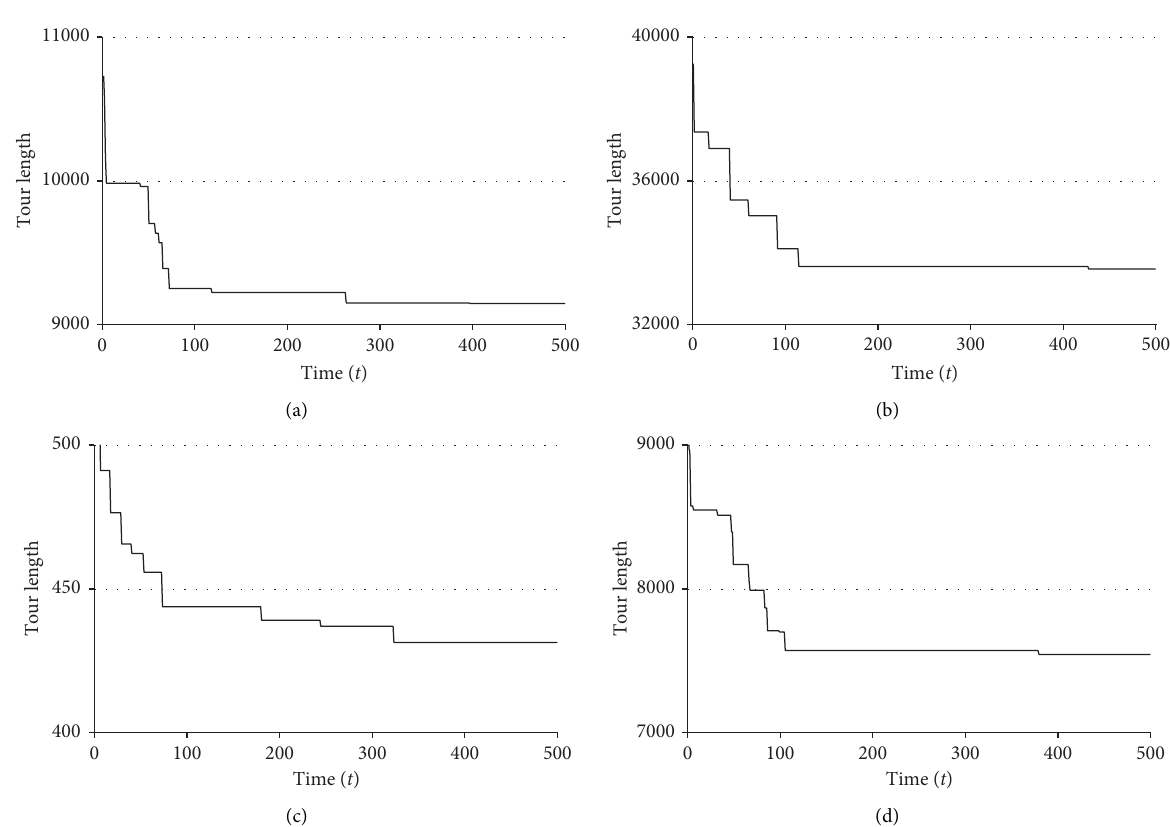
Figure 3: Best solution update in ASIM. (a) bayg29. (b) att48. (c) eil51. (d) berlin52.